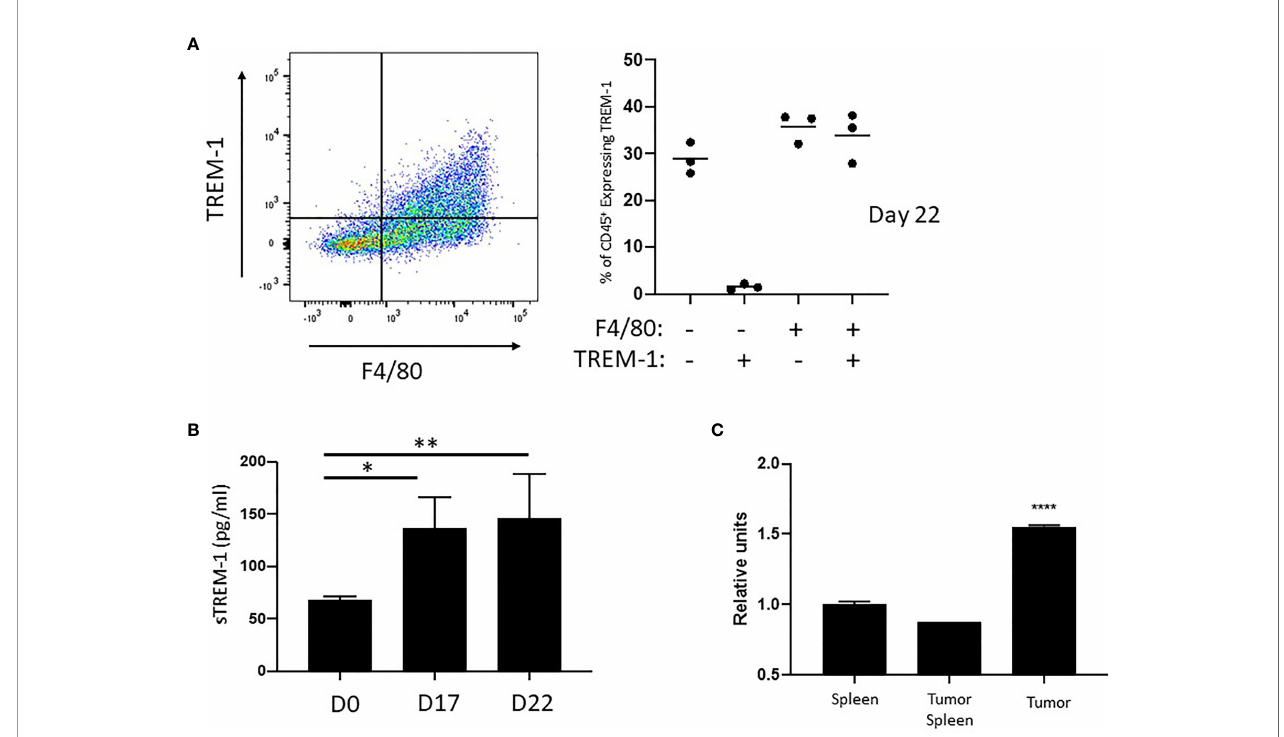
FIGURE 5 | Expression of TREM in RENCA tumors. (A) Representative FACS plot (left) showing the staining of RENCA-associated CD45 + leukocytes with TREM-1 and F4/80. Data from a quadrant analysis of three individual mice are grafted (right). Staining of the quadrants is noted below the graph. (B) Soluble TREM-1 as determined by ELISA. The mean +/- SEM for fi ve individual mice in each group is plotted. (C) qPCR analysis of Trem2 on RNA isolated from whole RENCA tumors (tumor) at day 22 after implantation. Relative values compared to splenocytes isolated from healthy mice (spleen) and splenocytes isolated from tumor-bearing mice (tumor spleen) are shown. * p < 0.05, **p < 0.01, and ****p <